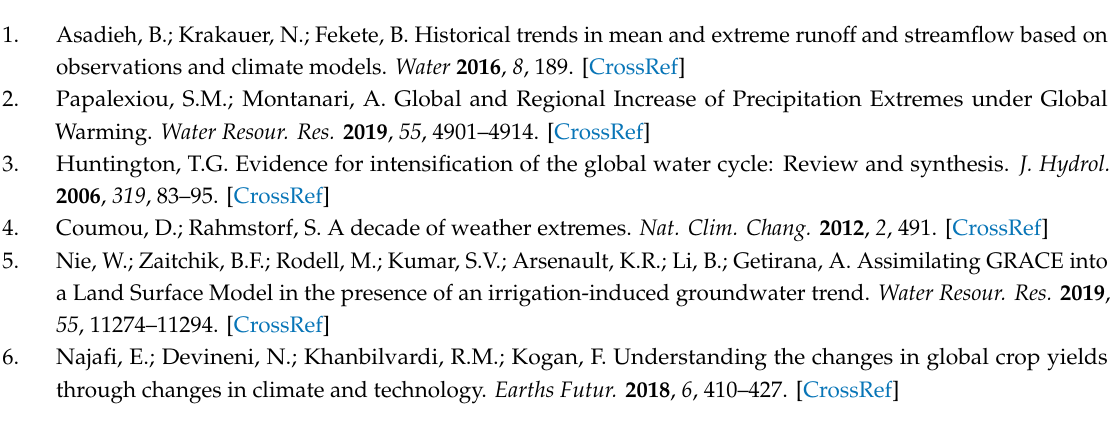
Table S1: alphabetized literature values of relative canopy interception, stemflow, and throughfall. Table S2: results of the Kolmogorov–Smirnov tests used to test for di ff erences in the distribution of interception, throughfall, and stemflow between paired crop types and for all crop data